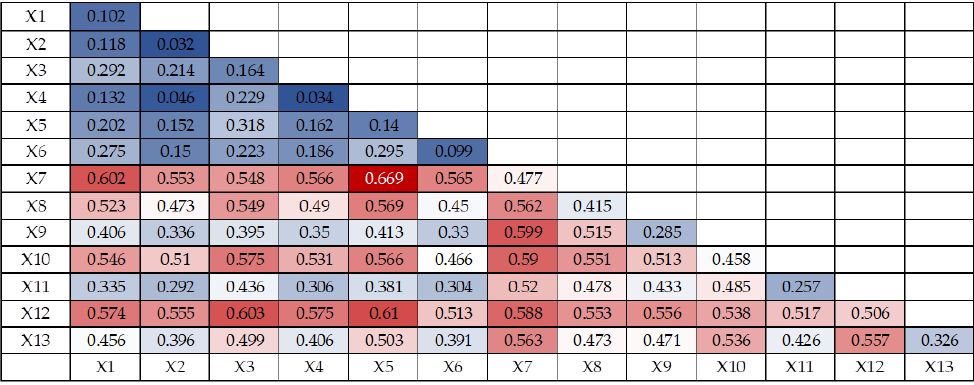
Figure 8. Ecological Vulnerability Interaction Detector Results in Shenyang in 2020. 3.4. Simulation Analysis of Ecological Vulnerability in Shenyang in 2025 With the aid of CA-Markov model in IDRISI software, the spatial layout of ecologi- cal vulnerability in Shenyang in 2020 was simulated based on the ecological vulnerability area transfer matrix of 2010–2015 and the ecological vulnerability suitability image set of Shenyang City in 2015 as the base period image, and the simulation results are shown in Figure 9. In this paper, Kappa coefficient is used to verify whether the simulated data of Shenyang in 2020 is consistent with the current situation data and to quantitatively evaluate the accuracy of model simulation. If Kappa ≥ 0 .75, then it indicates that the re- liability of the simulation results is high; if 0. 4 ≤ K app a ≤ 0 .75, then it indicates that the simulation is average; if 0. 4 ≤ K appa, then it indicates that the simulation is poor, and the calculation formula is shown as follows.